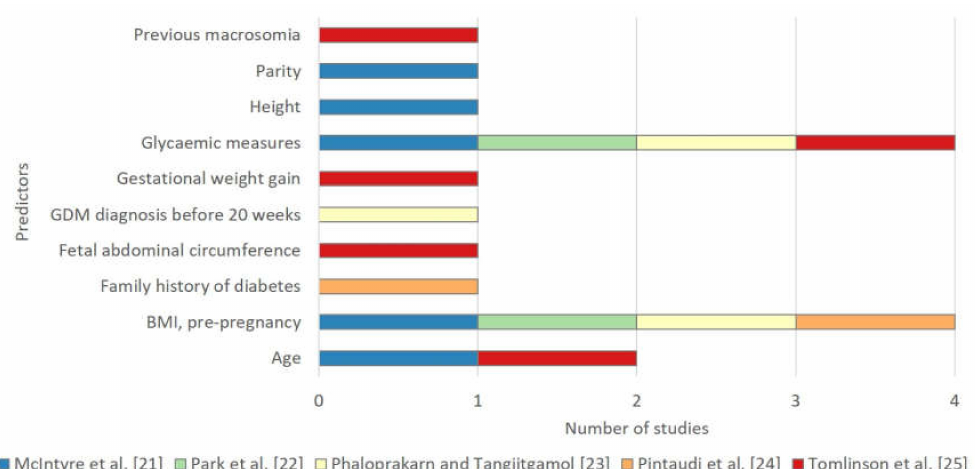
Figure 4. Selected predictors in final models for pregnancy complications in women with gestational